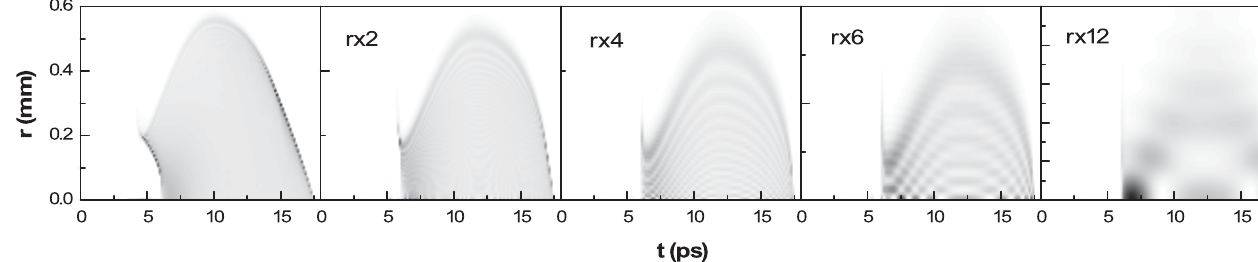
FIG. 3. (Color) Theoretically calculated spatiotemporal laser profiles with different input beam size (flat topped) using the same (cid:6) and (cid:7) as in Fig. 1(c). From left to right: P ¼ 25 , 12, 6, 4, and 2 mm. Note the different scales in r in each